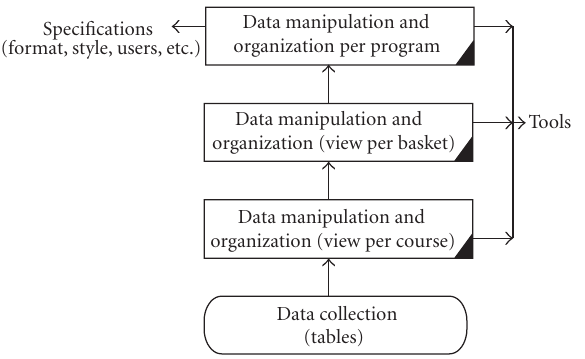
Figure 2: Data flow model for program